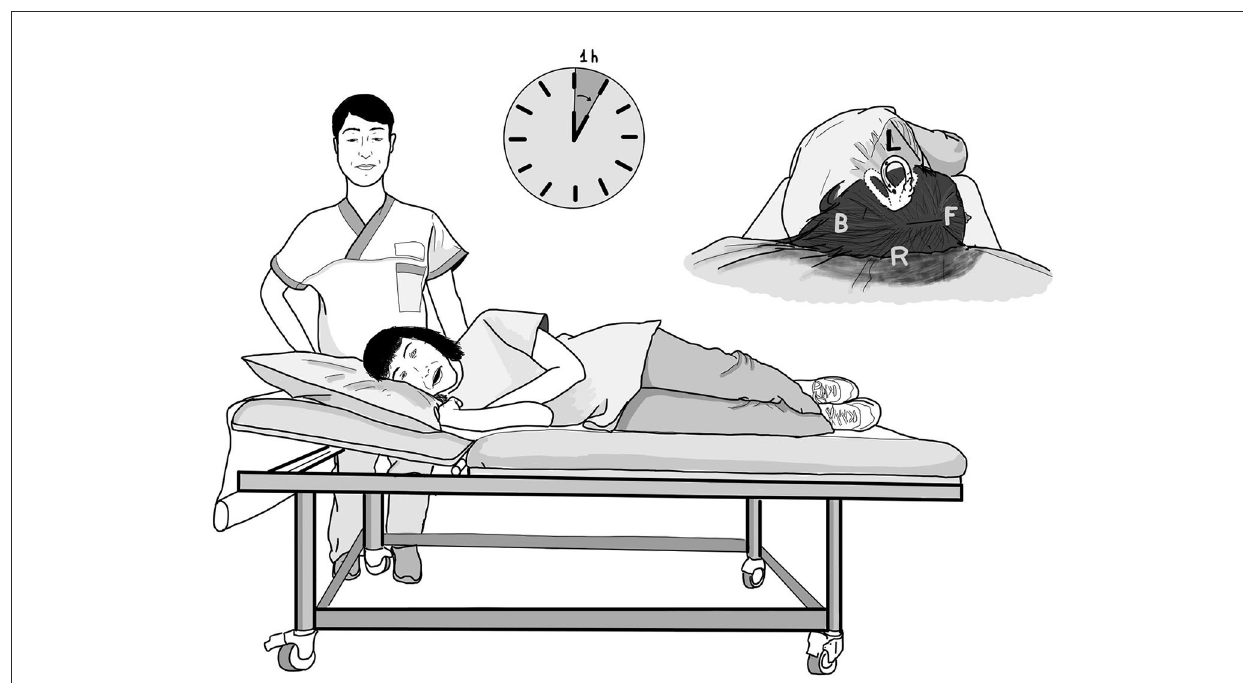
FIGURE2 The shortened forced position (SFP) in case of a left geotropic LSC BPPV. The patient lay for 1h in the right-side lateral position when supine. The therapy was performed in a medical environment under the supervision of a nurse. The debris, initially located in the posterior arm of the left LSC, gradually shifted toward the vestibule under the effects of gravity. F, front; B, back; L, left; R,